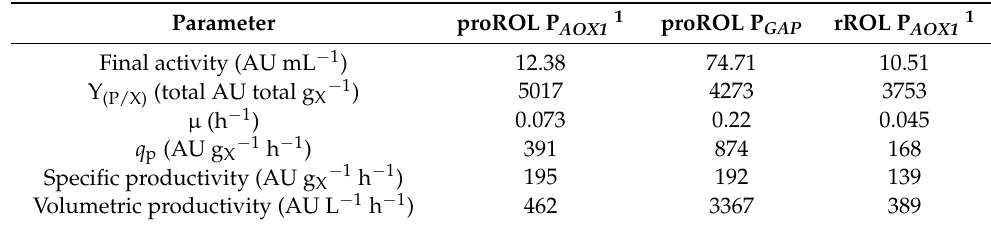
Table 1. Results obtained in batch tests involving proROL P AOX1 -strain and rROL P AOX1 -strain